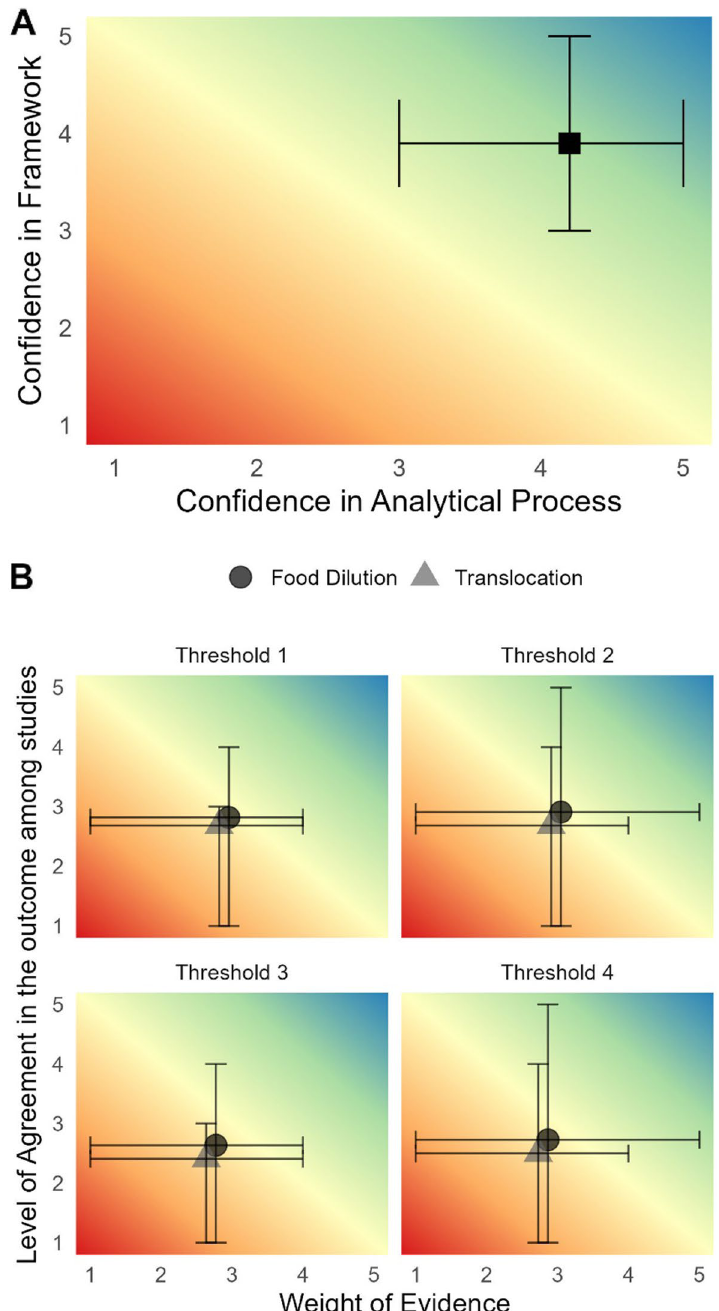
Fig. 2 Mean confidence scores for ( A ) the management framework and ( B ) threshold values. Whiskers represent the range of experts’ votes. Scoring scale: 1- very low, 2- low, 3- medium, 4- high and 5- very